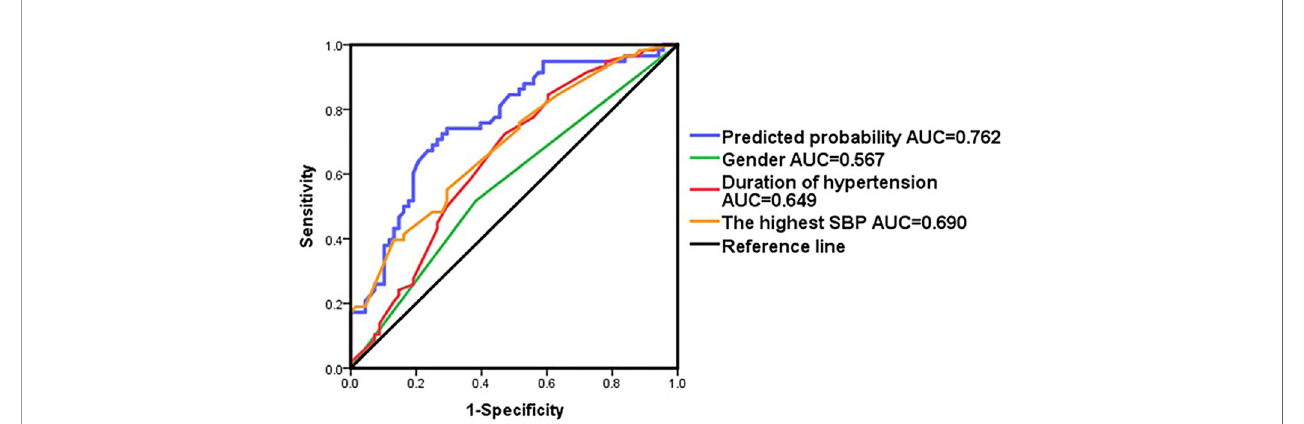
FIGURE 3 | ROC curve in patients by adding variables as gender,duration of hypertension and the highest SBP.